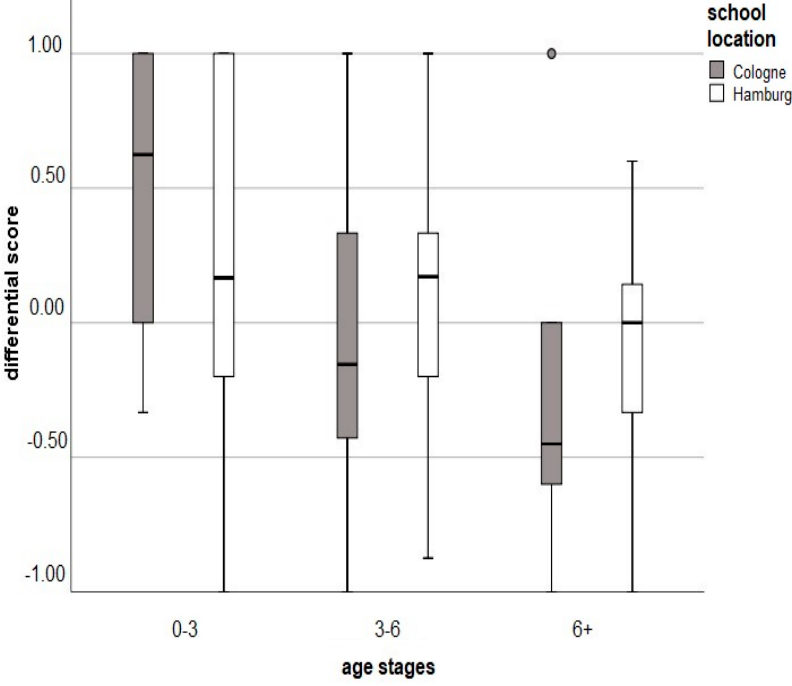
Figure 2. Box plot of the differential scores related to home language history across different age stages (from birth to 3 years old, from 3 to 6 years old, and at 6 years old) in the two groups of children (living in Cologne and Hamburg). The differential scores are calculated by subtracting the index related to the amount of language use in German (as extracted from the questionnaires) from the index related to the amount of language use in Italian, whereby a positive score indicates dominant language use in Italian and a negative score indicates dominant language use in Ger ‐ man.